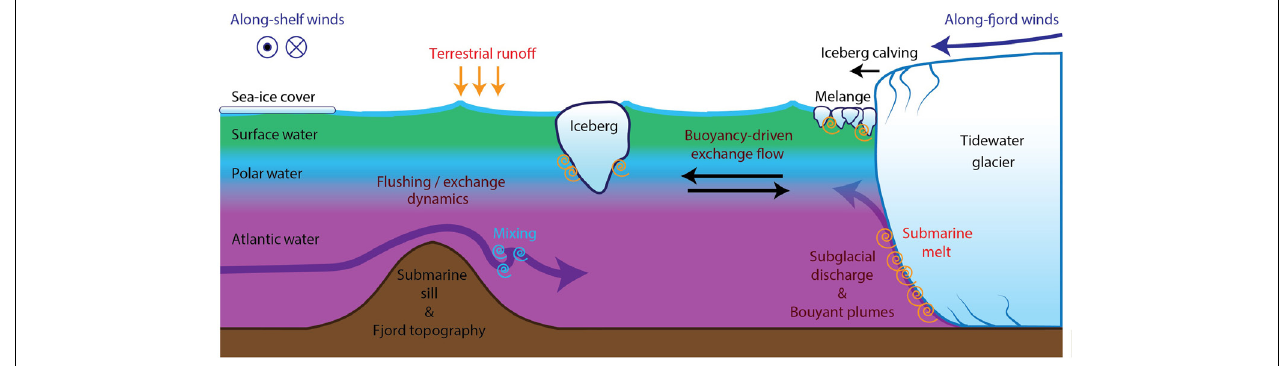
FIGURE 2 | Schematic of a Greenland glacier/fjord system showing relevant physical processes that govern circulation in the fjord and at the glacier-fjord boundary, typical stratification and water masses, and sources of freshwater to the fjord.